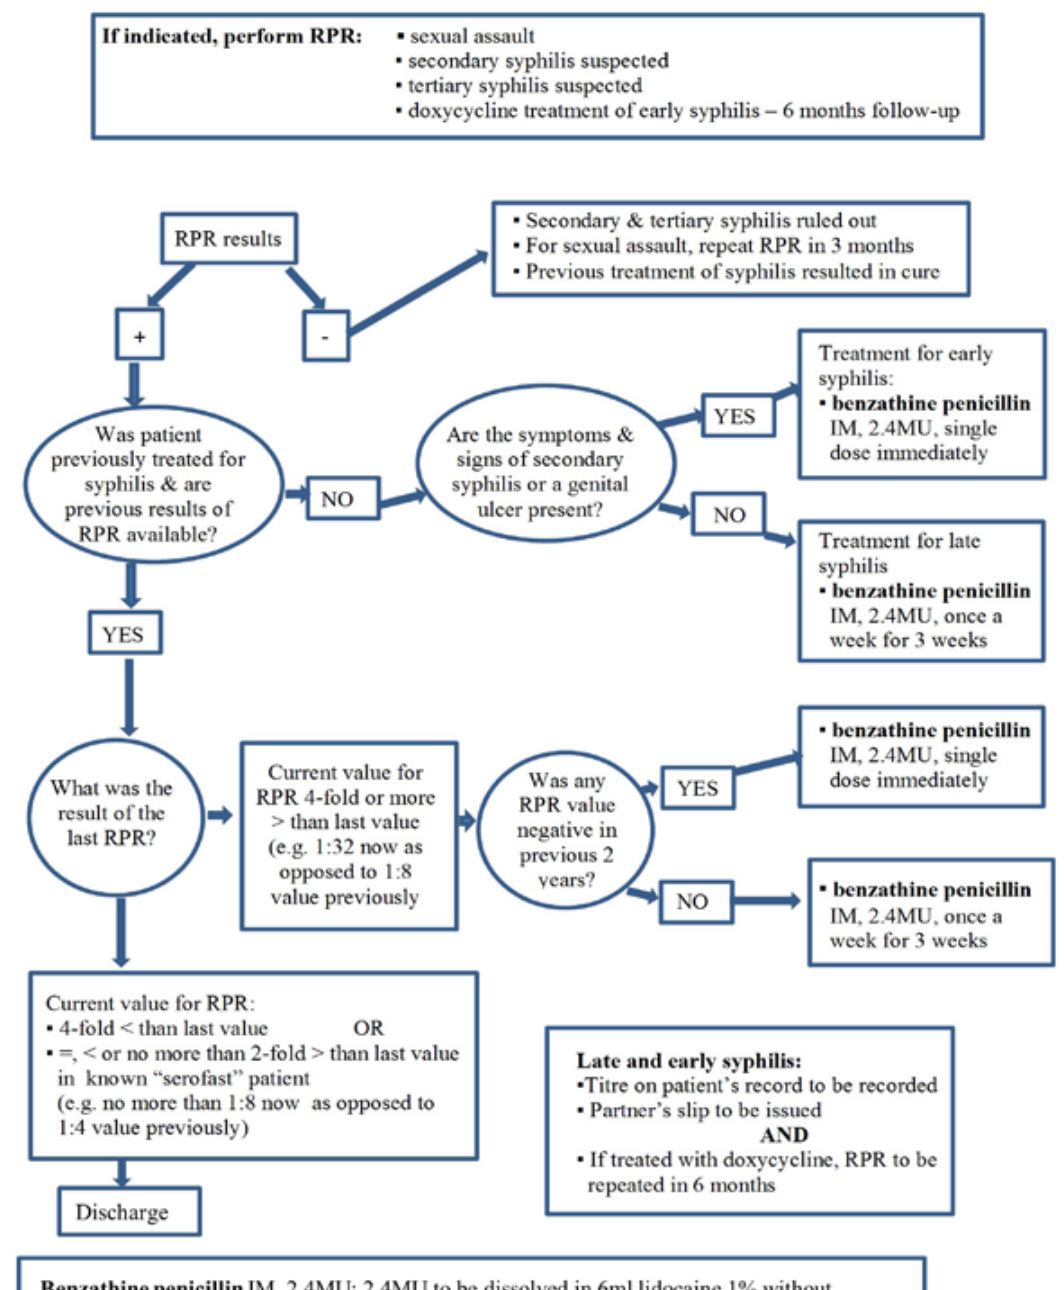
Figure 8: Flowchart of syndromic treatment of syphilis. (adapted from the revised syphilis flowchart of the Primary Health Care Standard Treatment Guidelines and Essential Drugs List, 2015)